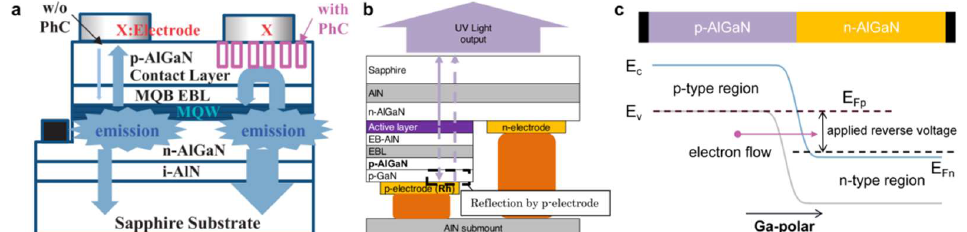
Figure 11. Schematic structure of ( a ) the LEDs with and without a PhC on the p-AlGaN contact layer [138] and ( b ) the flip-chip LED with two light paths [139]. ( c ) Schematic diagram of homogeneous tunnel junction structure and its corresponding energy band as well as carrier transport.